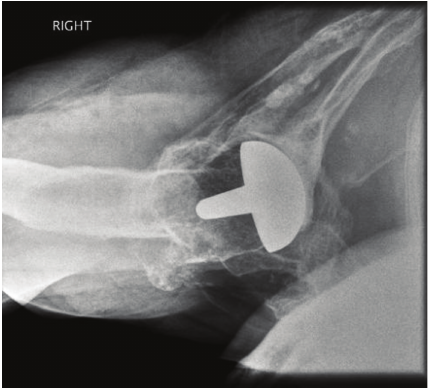
Figure 4: Axillary lateral radiograph of the right shoulder taken 4 years